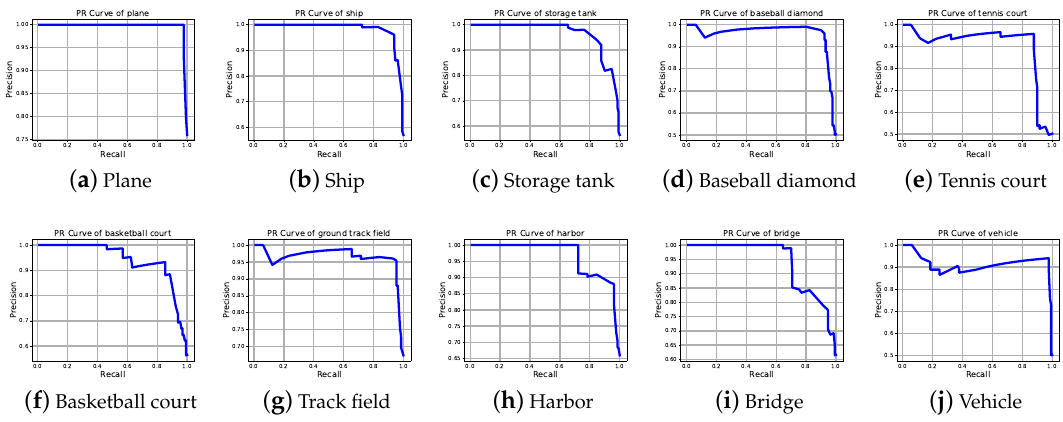
Figure 6. PR curves of different objects on NWPU VHR-10 dataset with threshold set to